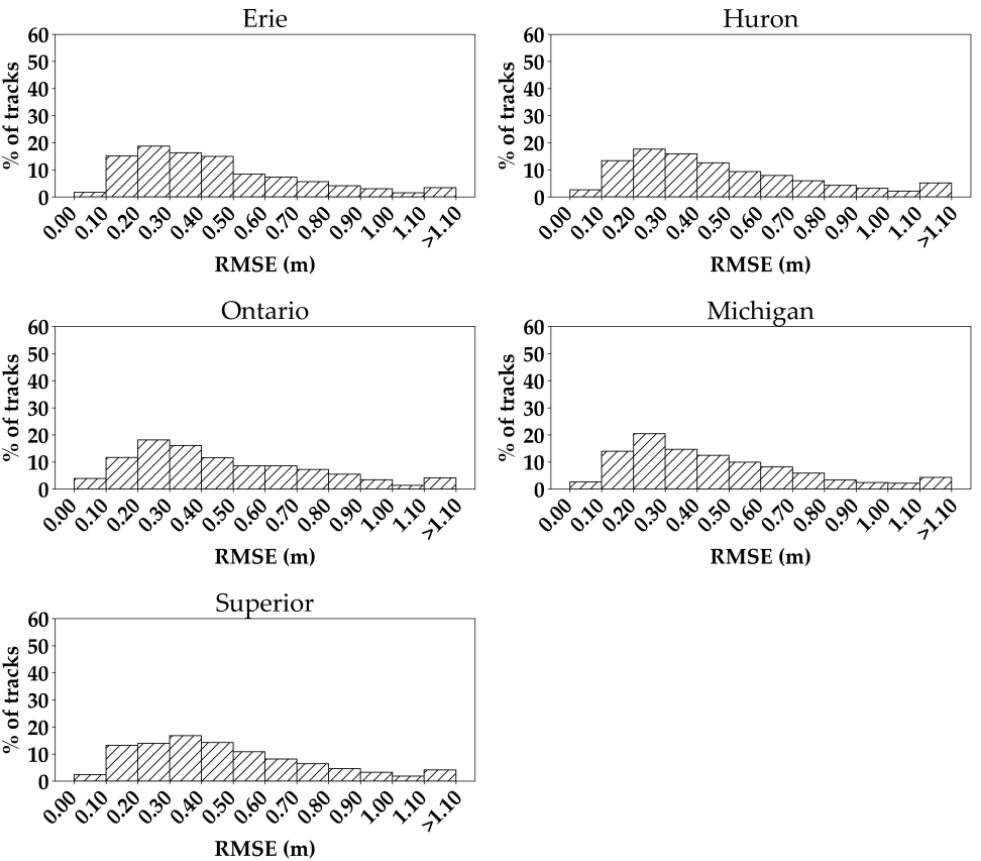
Figure 5. Distribution of the unbiased root mean squared error (ubRMSE) between GEDI shots and in situ elevations across the five studied lakes. The distribution corresponds to the ubRMSE of GEDI tracks (i.e., shots acquired on the same date with the same beam).